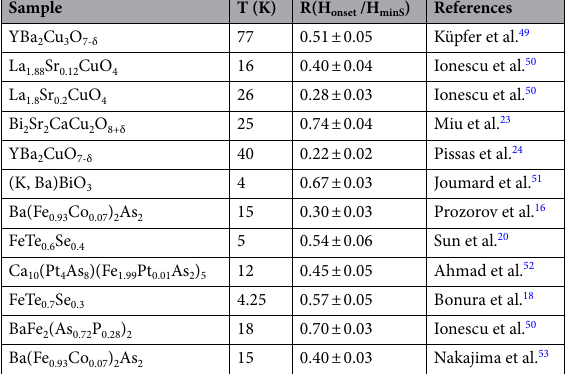
Table 1. Ratio H onset /H minS (R) for several type II superconductors.